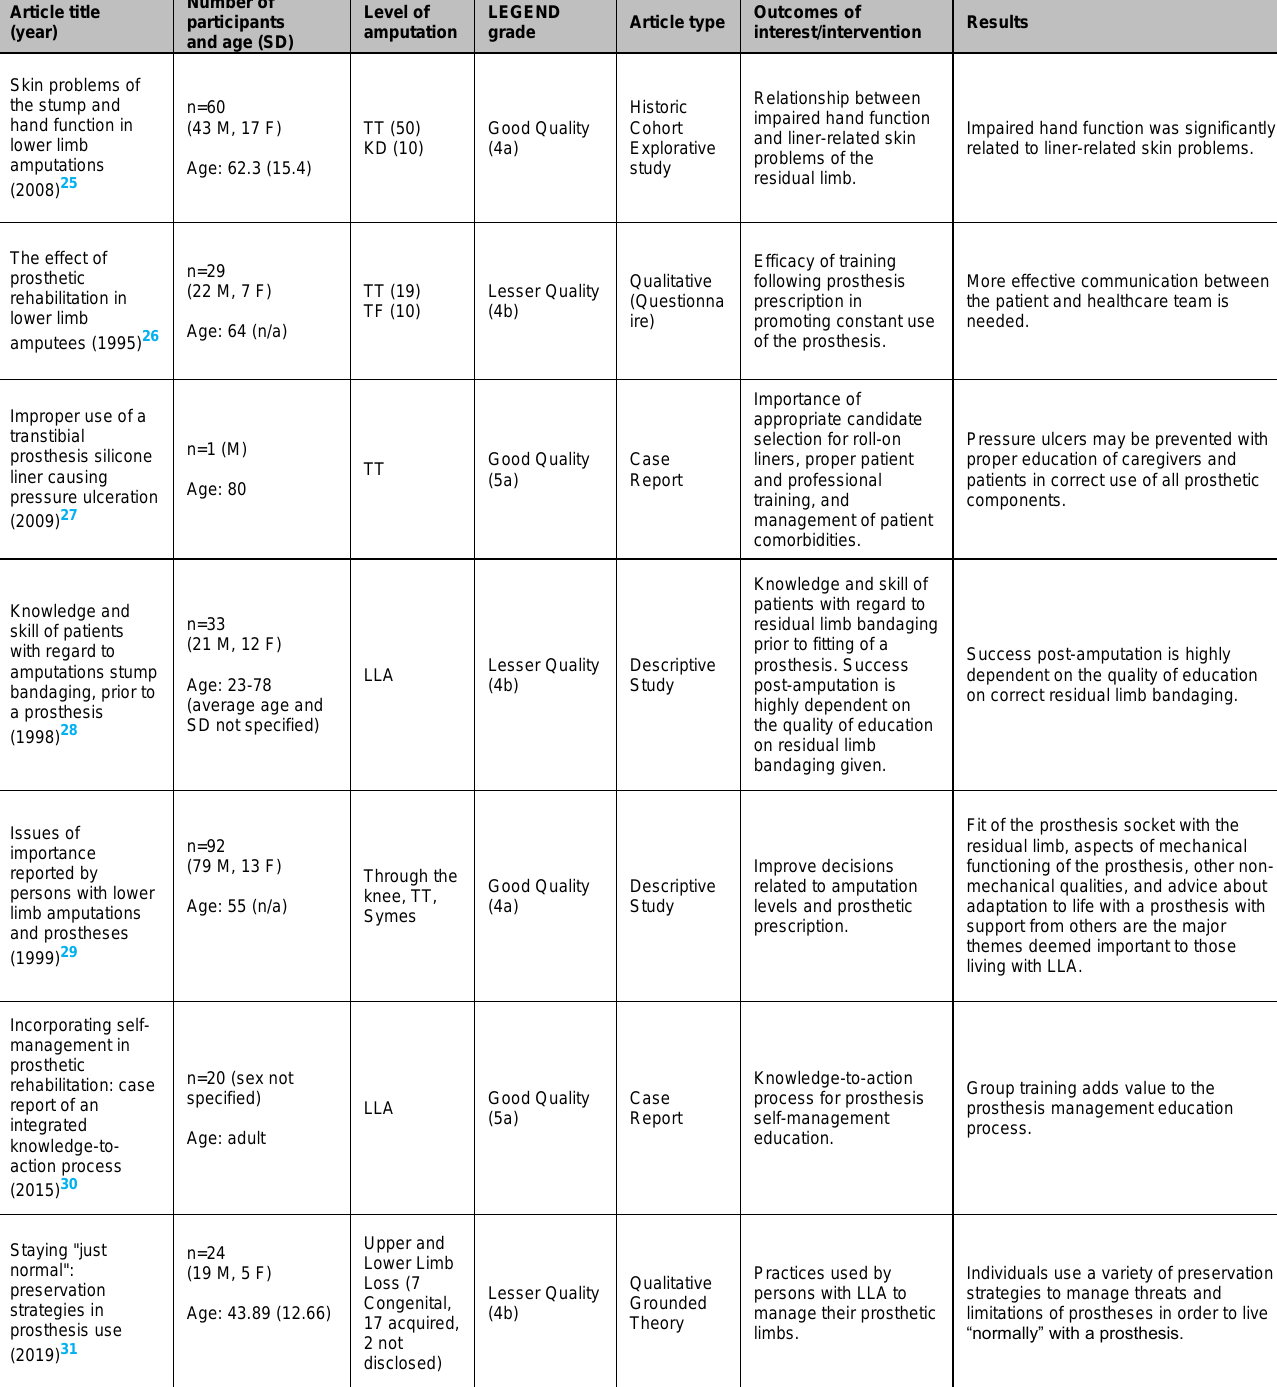
Table 3 : Overview of studies included in the literature